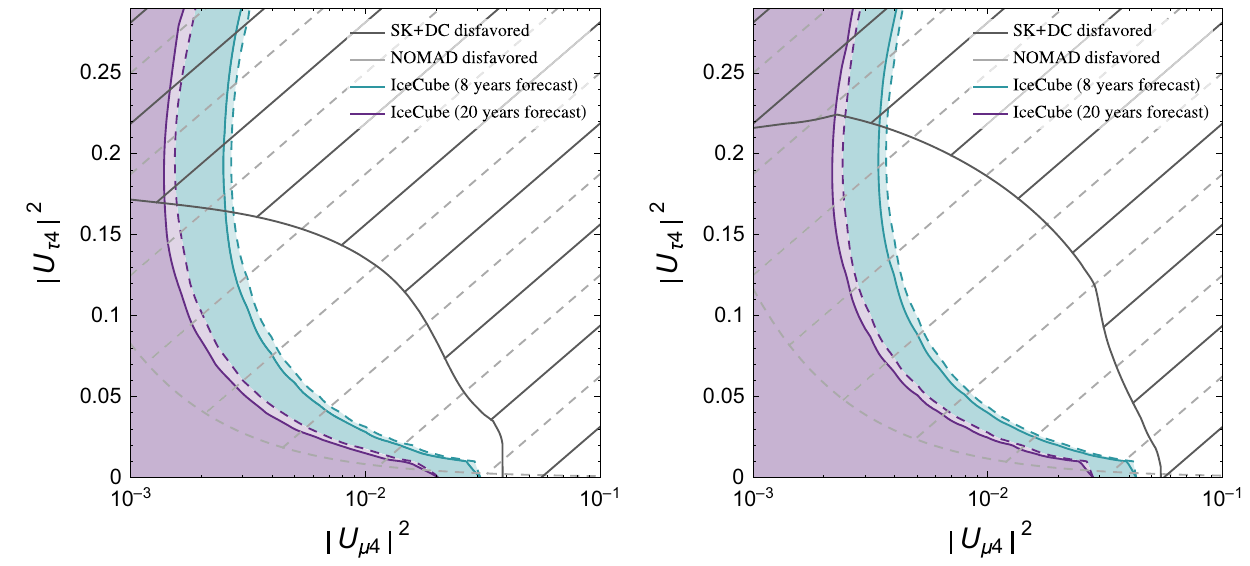
Fig. 3 The left (right) panel shows the expected constraints in absence of sterile neutrino mixing at 90% (99%) C.L. for the sterile mixing ele- ments from datasets composed of 8-year (cyan) or 20-year (purple) of IceCube data. The full (dashed) curves show the bounds for δ 24 = 0